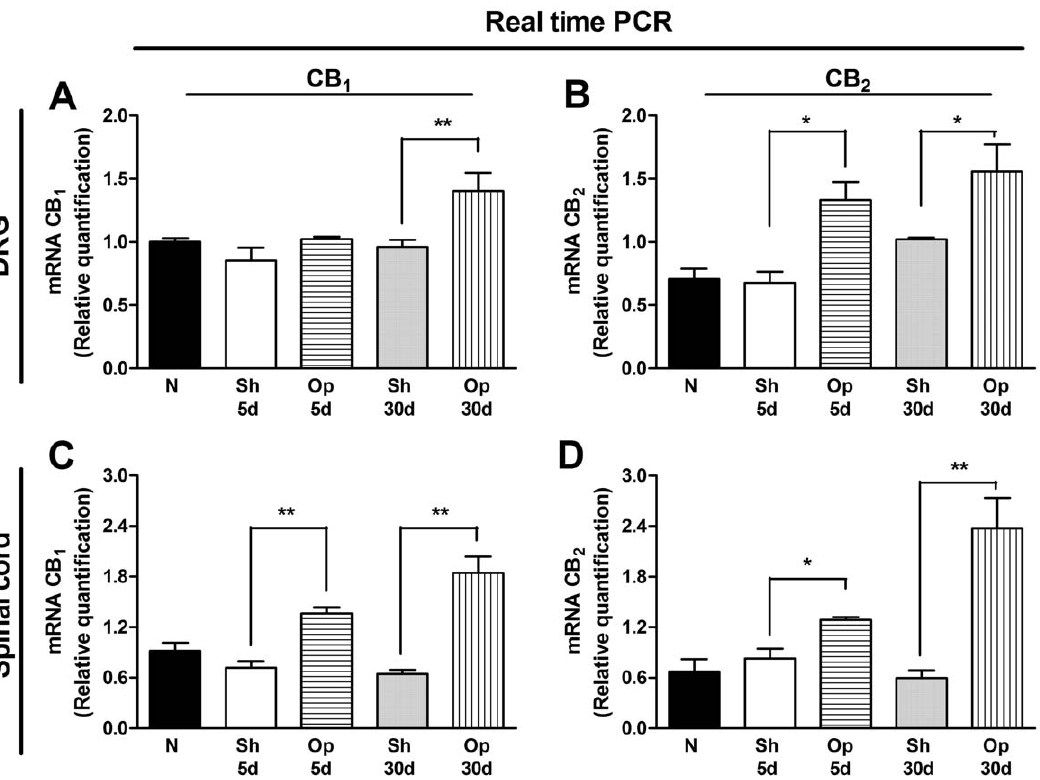
Figure 2. Evaluation of CB 1 receptor (CB 1 ) and CB 2 receptor (CB 2 ) mRNA levels in CNS structures of mice submitted to brachial plexus avulsion (BPA). The mRNA levels of the CB 1 and CB 2 receptors were evaluated in the dorsal root ganglia (DRG) (A and B) and dorsal horn of the spinal cord (C and D), respectively. GAPDH mRNA was used to normalize the relative amount of mRNA. N (naı¨ve mice), Sh 5 d (sham-operated group 5 days after BPA), Op 5 d (operated group 5 days after BPA), Sh 30 d (sham-operated group 30 days after BPA) and Op 30 d (operated group 30 days after BPA). Data are expressed as mean 6 SEM (n=3/group), and are representative of three independent experiments. *p , 0.05 and **p , 0.01, significantly different from the respective sham-operated group (one-way ANOVA with Bonferroni’s post hoc